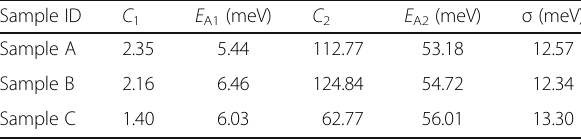
Table 1 Obtained fitting parameters: activation energies ( E A1 and E A2 ), constants ( C 1 and C 2 ), and localization energy ( σ ) Sample ID C 1 E A1 (meV) C 2 E A2 (meV) σ (meV) Sample A Sample